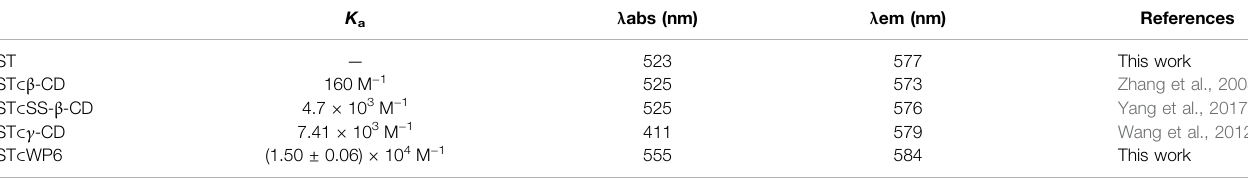
TABLE 1 | Association constants ( K a ) and optical spectroscopic data for the complexes of ST with WP6 and other macrocycles.